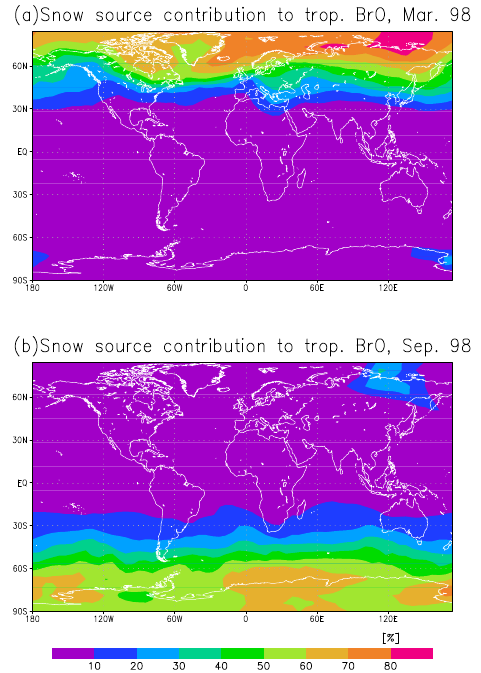
Fig. 6. Percentage contribution of blowing snow source to the sim- ulated tropospheric column BrO in (a) March and (b) September of 1998. Values are calculated according to the formula: (BASE run – OCEAN run)/(BASE run) × 100%).